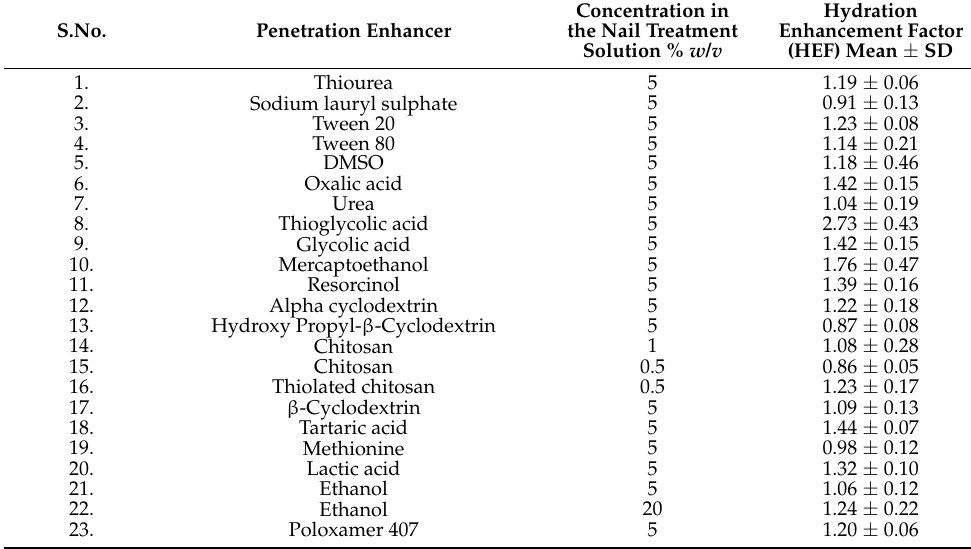
Table 1. Comparison of HEF values of screened chemicals as potential nail penetration enhancers.